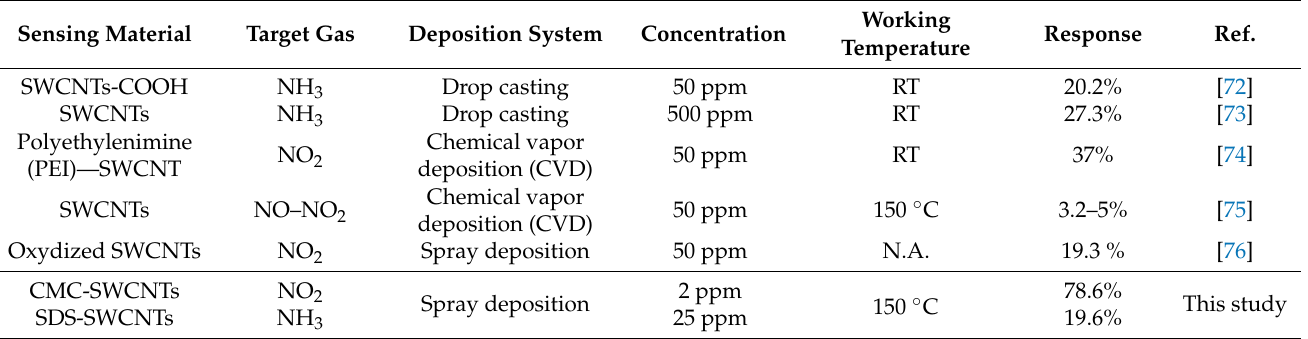
Table 4. Overview of sensing performance of SWCNT-based gas sensors towards different tar- get